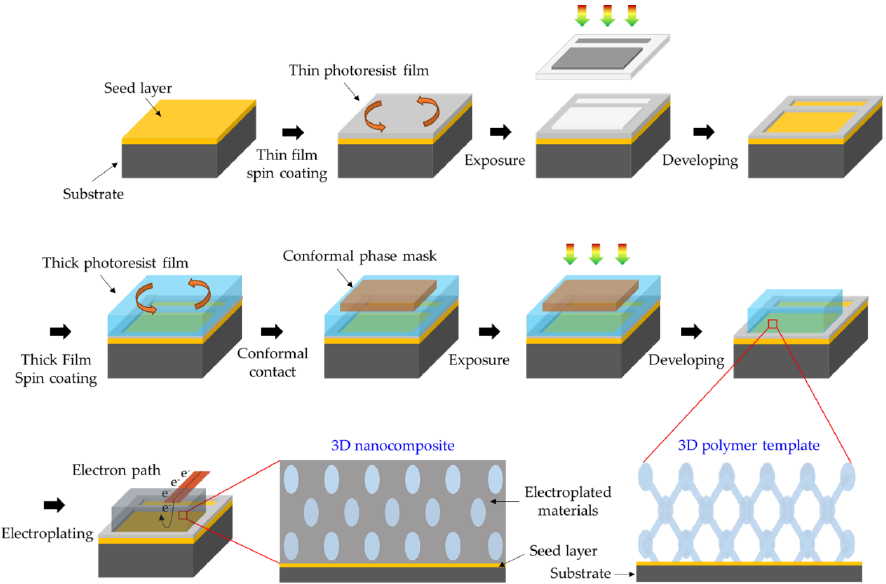
Figure 4. Schematic illustration of “window” process for electroplating inorganic materials into 3D porous templates.